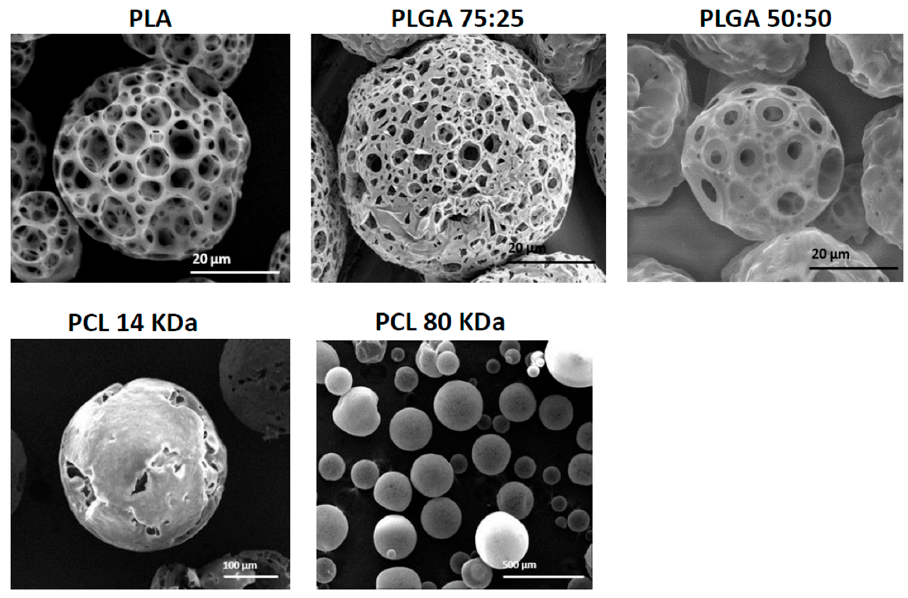
Figure 4. SEM images showing the morphology of porous and non-porous microspheres obtained with different polymers and molecular weights using batch synthesis. PLA, PLGA 75:25, PLGA 50:50, PCL 14 kDa and PCL 80 kDa.